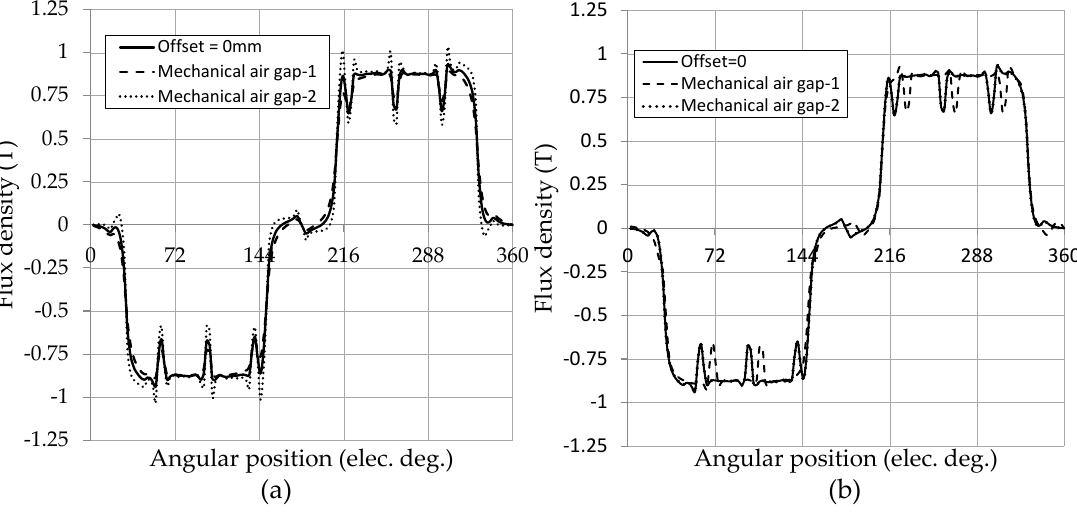
(b)(a) Figure 11. No-load air-gap flux density distribution, z-component. Both machines with misalignment effects are compared with a “healthy” machine: ( a ) AF PMSM with 1533 normalized air-gap offset; ( b ) machine with 10 electrical degrees stator offset.